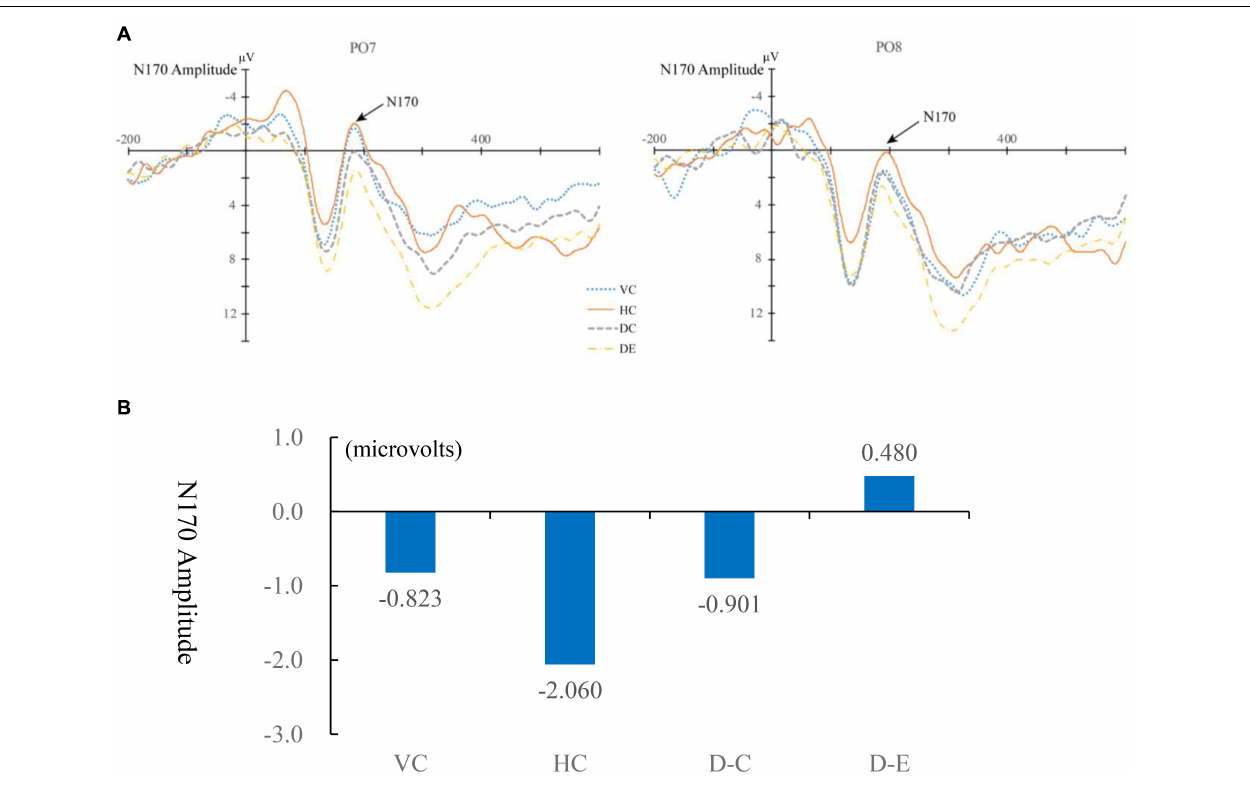
FIGURE 3 | (A) Event-related potential (ERP) waveforms of the N170 under four conditions for children for the left (PO7) and right (PO8) parietal leads. VC, viewing Chinese; HC, handwriting Chinese; DC, drawing followed by Chinese recognition; DE, drawing followed by English recognition. (B) Differences between the four conditions for children in the amplitude of